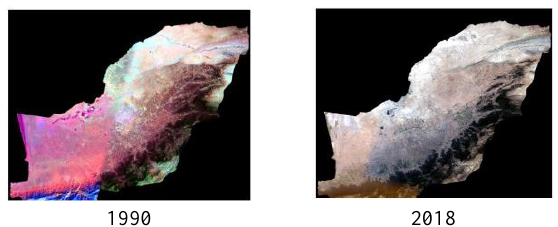
Figure 1. True colour composite of study area for Landsat